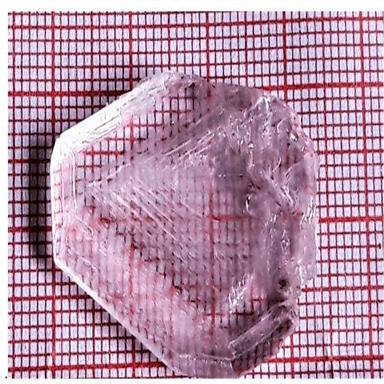
Image of UGA single crystal.